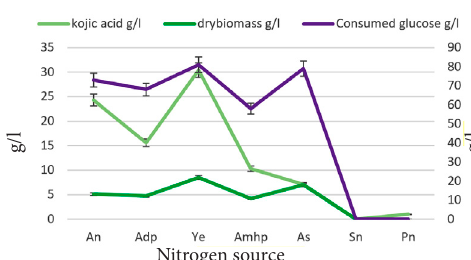
Fig. 4. Effect of different nitrogen source on synthesis of kojic acid drymass and consumption of sugar by A.flavus